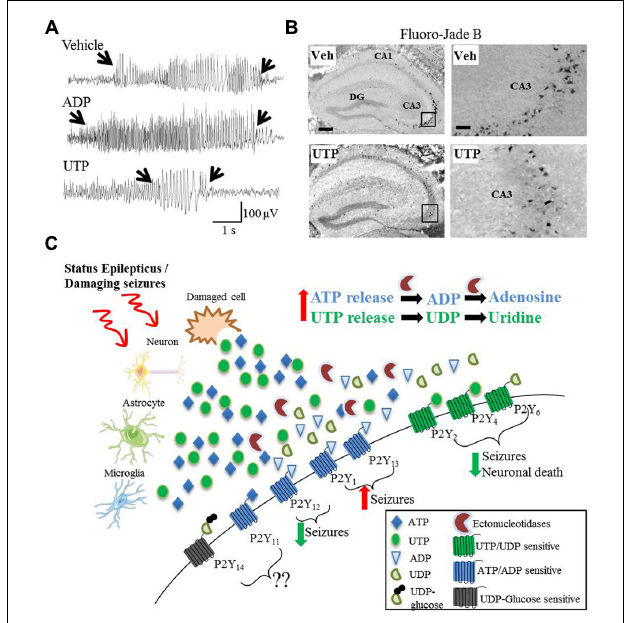
FIGURE 1 | Divergent effects on seizures and seizure-induced pathology of different P2Y agonists. (A) Representative EEG traces recorded during intraamygdala KA-induced status epilepticus showing pro-convulsive effects of ADP treatment, while UTP acts as potent anti-convulsive. (B) UTP protects against neuronal cell death following status epilepticus, visualized with the neuronal-cell death marker Fluoro-Jade B. (C) Hypothetical model of P2Y receptor function during and after status epilepticus or damaging seizures. During and following status epilepticus, purines (e.g., ATP and UTP) are actively released from different cell types including neurons, astrocytes and microglia or enter the extracellular space from damaged/necrotic cells. While the activation of UTP/UDP-sensitive P2Y receptors (P2Y 2 , P2Y 4 , and P2Y 6 ) may has anticonvulsive and neuroprotective effects, the activation of ATP/ADP-sensitive P2Y receptors (P2Y 1 and P2Y 13 ) may be pro-convulsive. The role of P2Y 11 and P2Y 14 have not been studied so far and therefore are unknown. Counterintuitively, P2Y 12 is ATP/ADP-sensitive, but seems to be anticonvulsive and